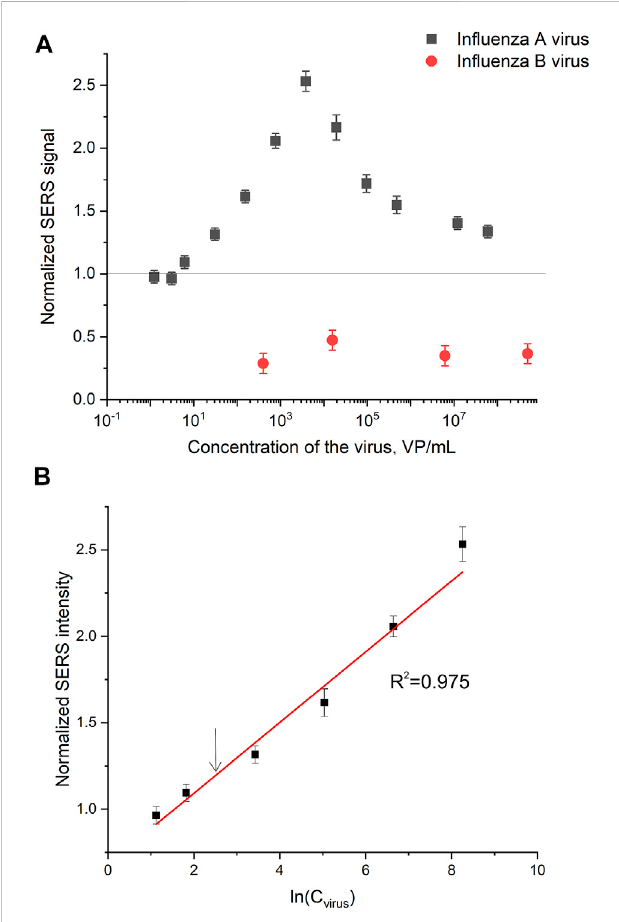
A concentration dependence of a normalized surface-enhanced Raman spectrum intensity of signal from Cyanine-3 reporter on the concentration of in fl uenza A virus and in fl uenza B virus (A) . The part of the dependence with a monotonous increase of the signal was used to calculate the limit of detection that is indicated by an arrow (B) .